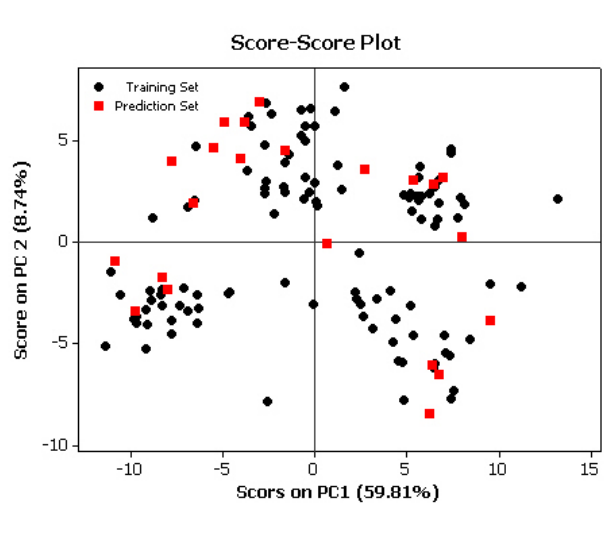
Figure 2. Score-Score